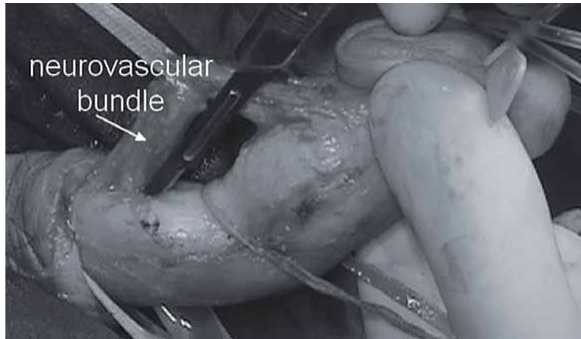
Figure 2 - Induced erection to observe the curvature.